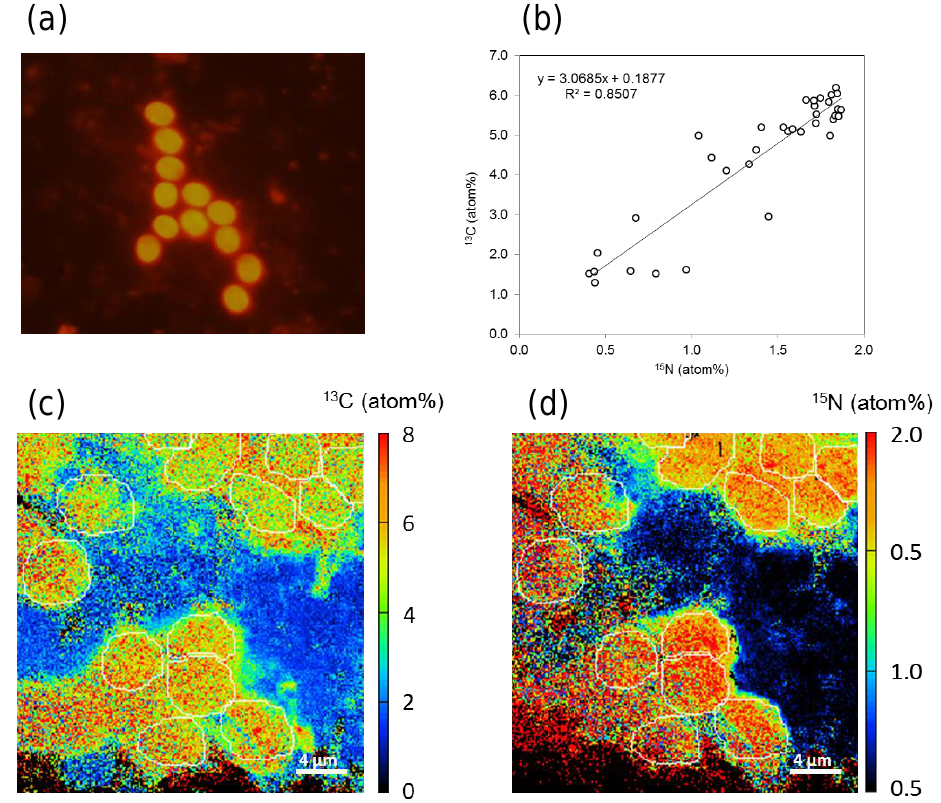
Figure 6. (a) Green excitation (510–560nm) epifluorescent micrographs of UCYN-C, (b) 13 C and 15 N isotopic enrichment (at.%) in individual UCYN-C cells on day 17 in M2, and (c, d) nanoSIMS images showing the 13 C (c) and 15 N (d) enrichment of individual UCYN-C cells after 24h of incubation. The white outlines show regions of interest (ROIs), which were used to estimate the 13 C / 12 C and 15 N / 14 N